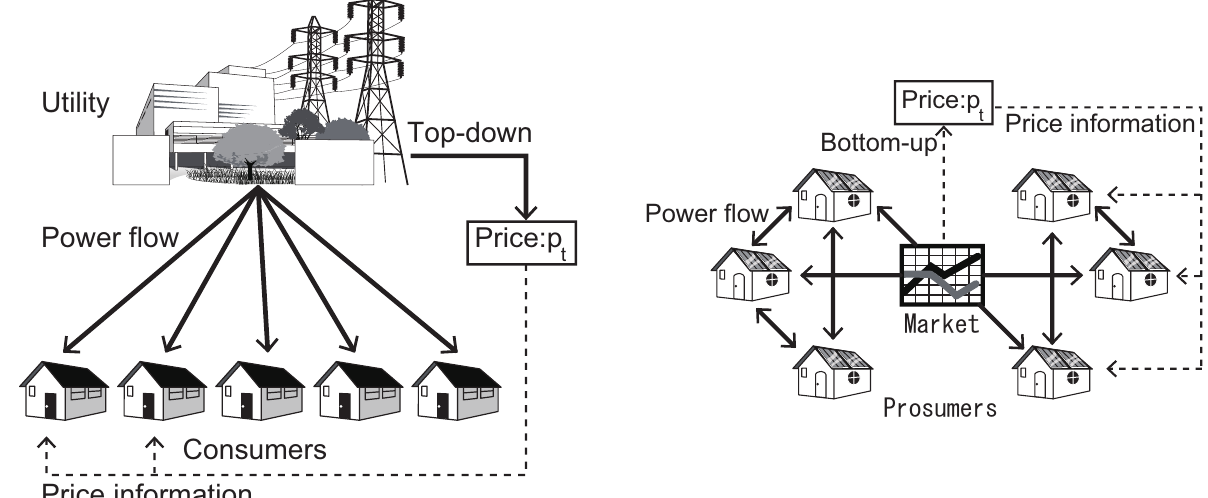
Figure 2. ( Left ) Real-time pricing in a conventional power grid; and ( right ) double auction pricing mechanism in a regional prosumers’ electricity